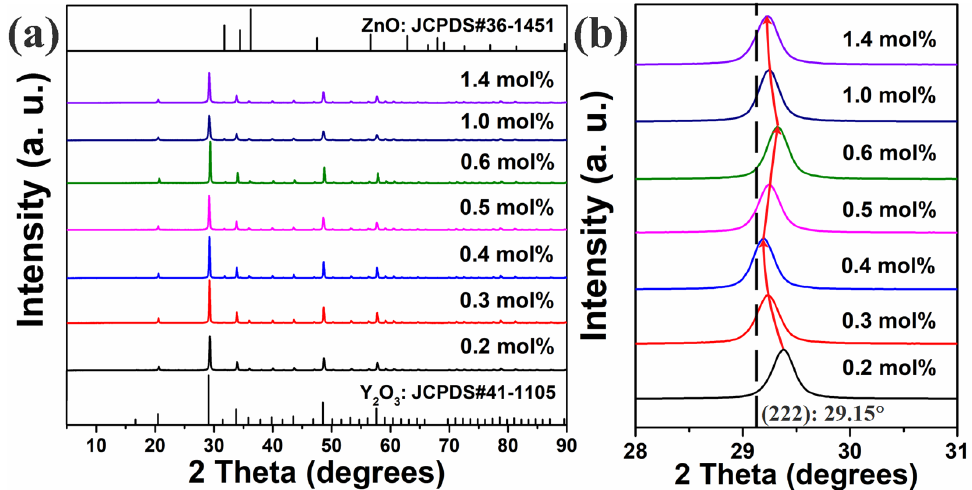
Figure 2. ( a ) Sample XRD patterns and ( b ) corresponding (222)-plane peak shifts.